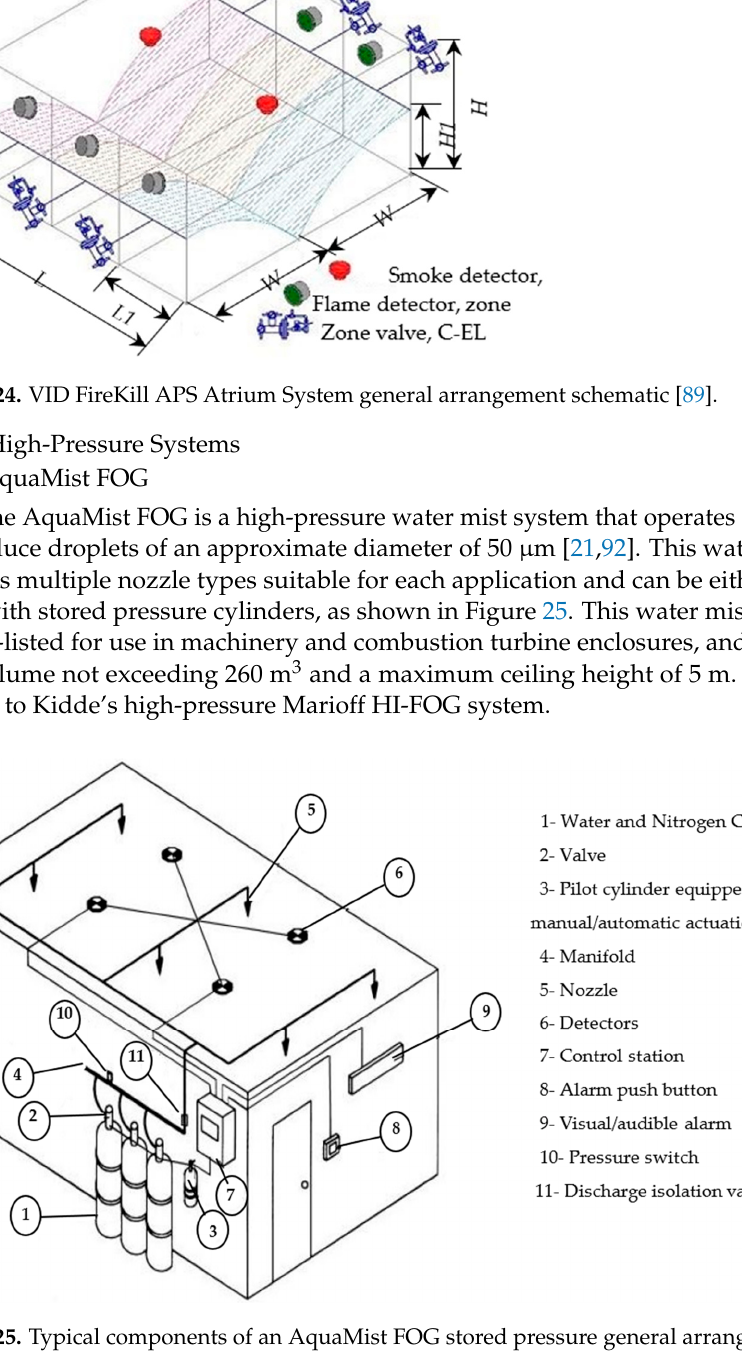
Figure 25. Typical components of an AquaMist FOG stored pressure general arrangement [92].